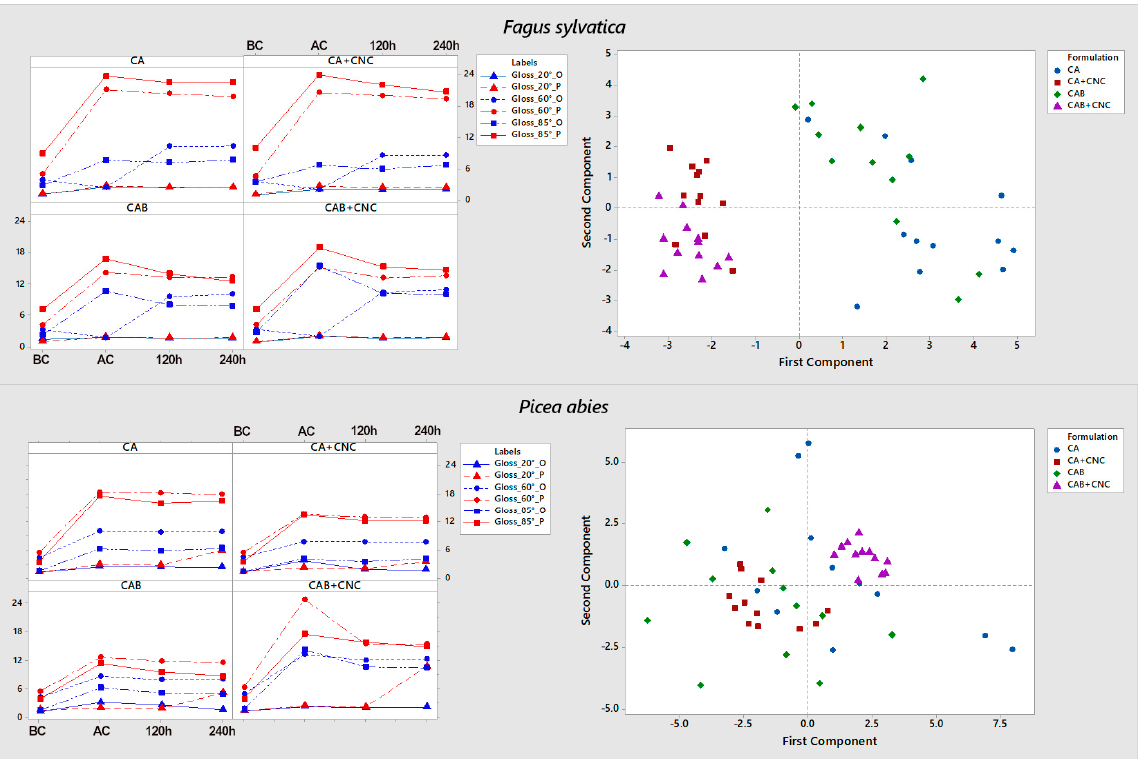
Figure 5. Gloss analysis. Mean plot ( left ) and PCA ( right ) for beech (F) and spruce (P) samples. BC: Before coating. AC: After coating. 120 h: After xenon exposure for 120 h. 240 h: After xenon